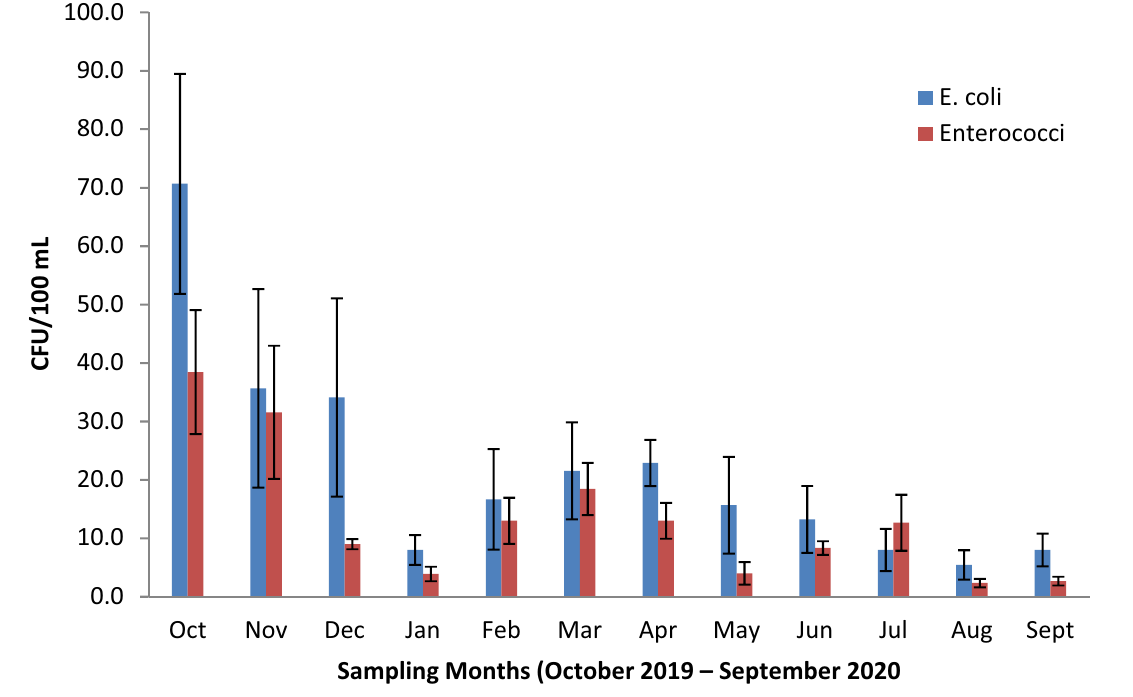
Table 3 Seasonal variation of FIB in Lake Bunyonyi (October